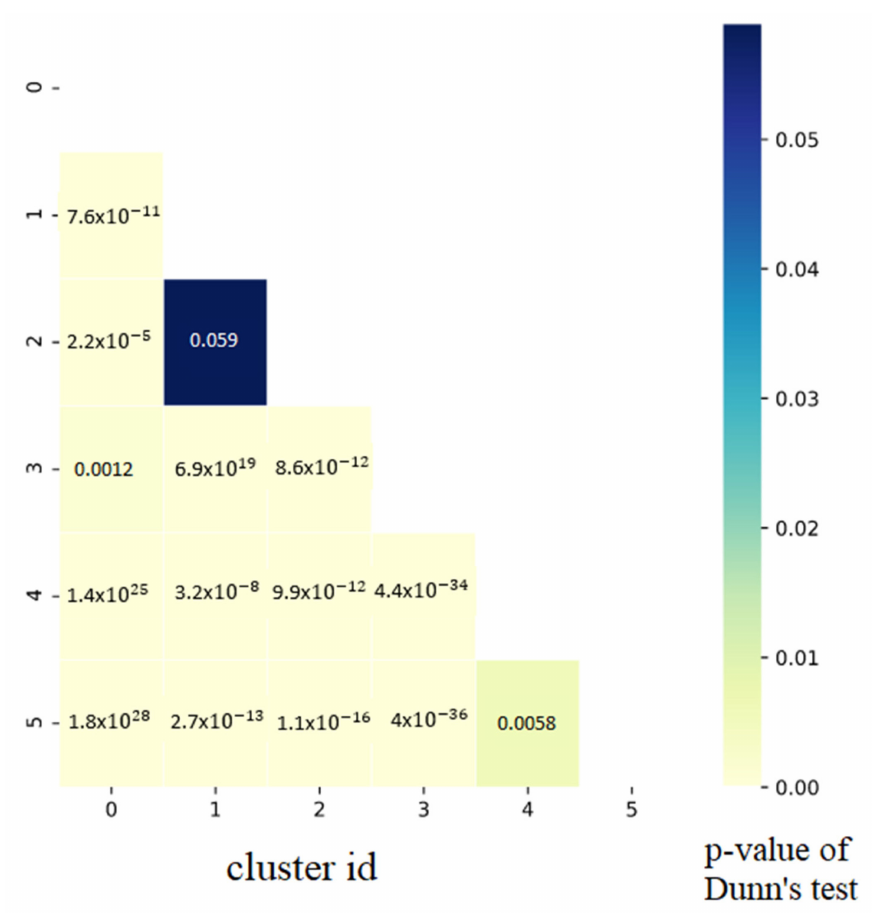
Figure 15. The results of Dunn’s test were applied to each cluster and used to compare the means between the